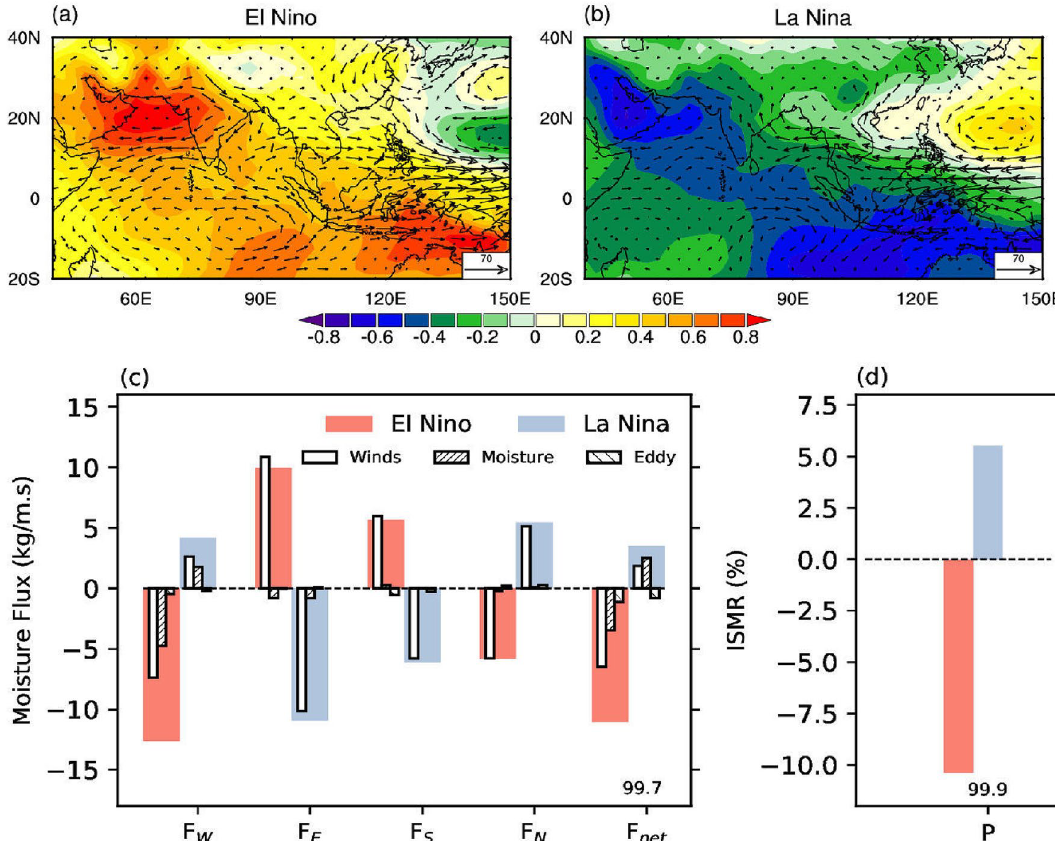
Figure 3. The teleconnection to El Nino Southern Oscillation (ENSO). Composite change in the anomalous surface pressure hPa and vertically integrated moisture flux vector ( kgm − 1 s − 1 ) during ( a ) El Nino and ( b ) La Nina. ( c ) Shows the vertically integrated moisture flux anomalies and its decomposition along the four boundaries (west ( F W ), east ( F E ), south ( F S ), and north ( F N )) and net moisture convergence ( F net ) over region marked as ABCD in Fig. 1a, for El Nino (red) and La Nina (blue) years. The contribution to total moisture ¯(cid:3) Vq (cid:4) (cid:5) ), and eddy flux ( (cid:2)(cid:3) V (cid:4) q (cid:4) (cid:5) ). ( d ) The flux (solid fill) and its components: due to winds ( (cid:2)(cid:3) V (cid:4) ¯ q (cid:5) ), moisture ( (cid:2) corresponding change in the Indian summer monsoon rainfall (ISMR) during El Nino and La Nina. The number along F net and P represents the significance level at which the hypothesis that means are the same for ENSO years is rejected. This figure was created using NCL version 6.4.0 (https:// www. ncl. ucar.